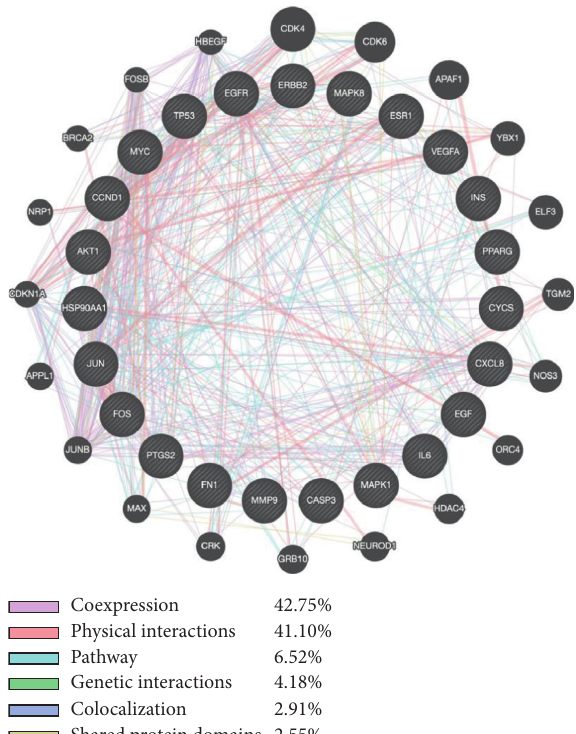
Figure 2: Protein network of core target genes by GeneMANIA. Black nodes represent target proteins, and connecting colors indicate different